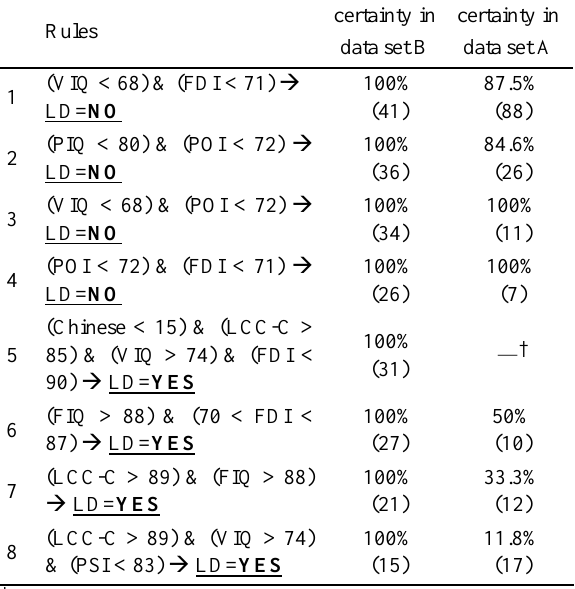
Table 9. Rules extracted from experiment 1 using data set B, with each rule being the one that receives the most support within its class. (The number within parenthesis represents the support when applying the rule to the specific data